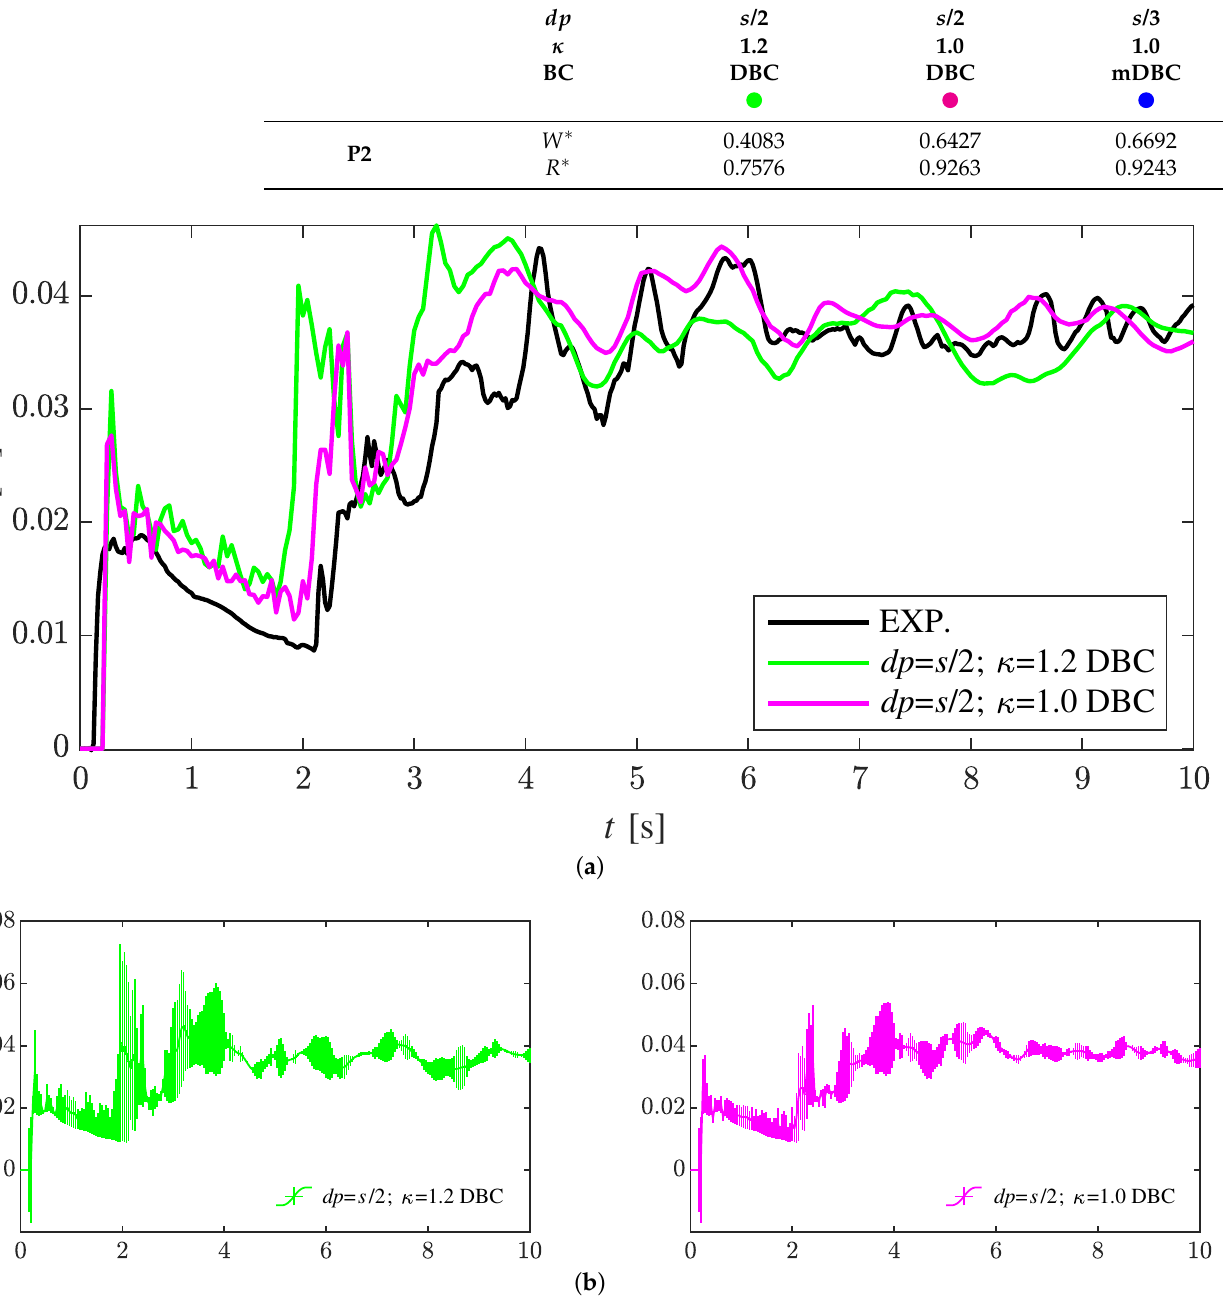
Figure 7. Comparison in P2 ( a ) and relative local elevation error ( b ) with dp = s /2, DBC and different values of κ